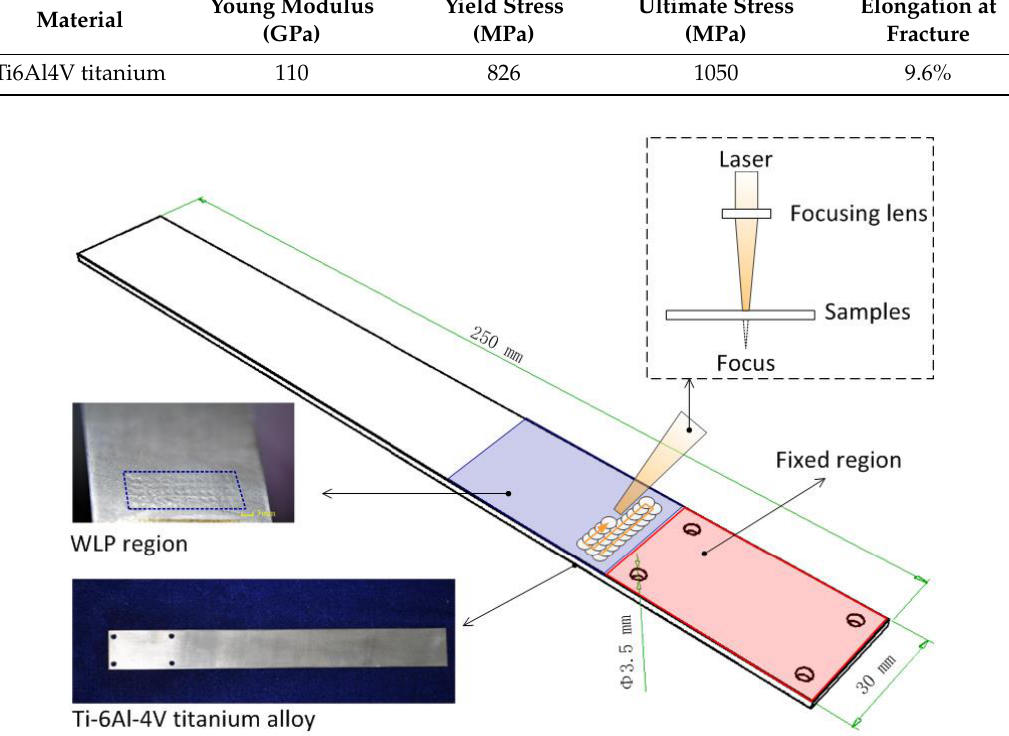
Figure 1. Ti6Al4V specimens and WLSP processed area.